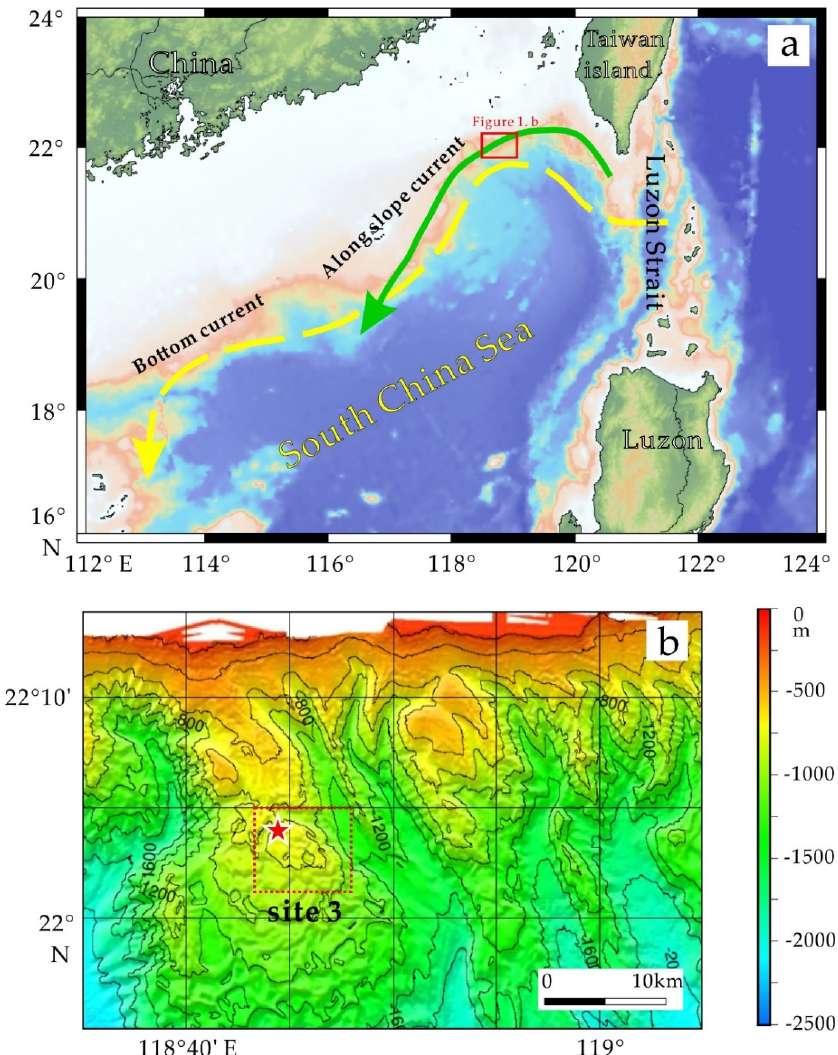
Figure 1. The topography of the northern South China Sea and the regional setting of the study area. ( a ) Deepwater-bottom-current and along-slope-current data are taken from Liu et al. [31] and Xie et al. [38]. Base map was created by using GeoMapApp. ( b ) Sample locations of tubular carbonates in this study (red star); bathymetric map from [19]. The red dotted rectangle indicates the location of Site 3.